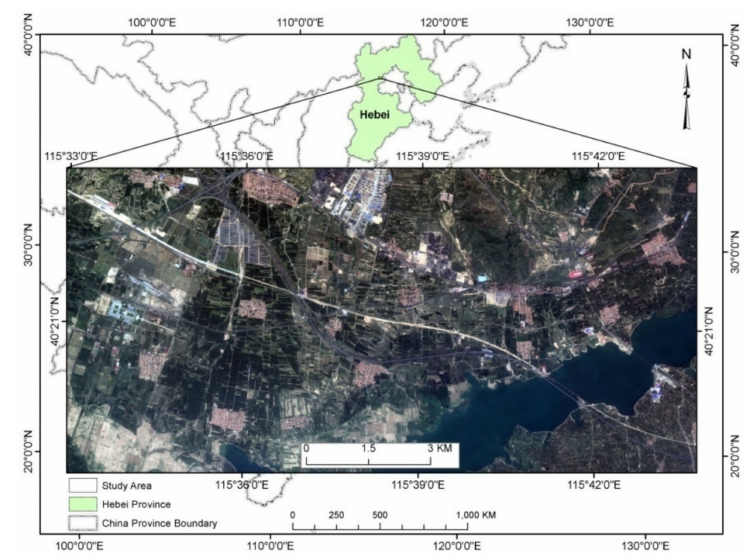
Figure 1. Location of study area.